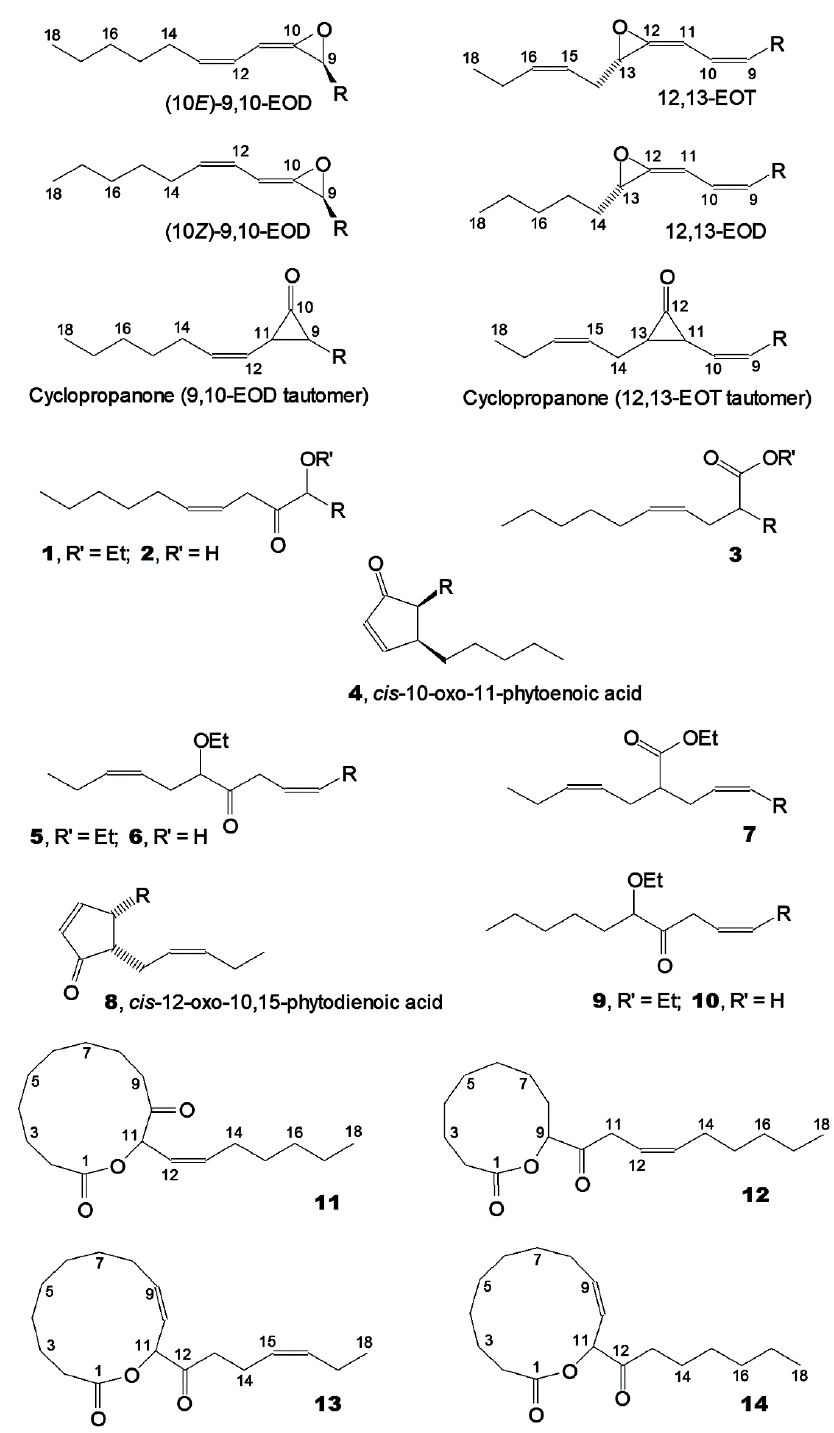
Figure 1. The structural formulae of the short-lived AOS products, allene oxides, their valence tautomers cyclopropanones and the products of their conversions detected in the present work. R = -(CH 2 ) 7 COOH.